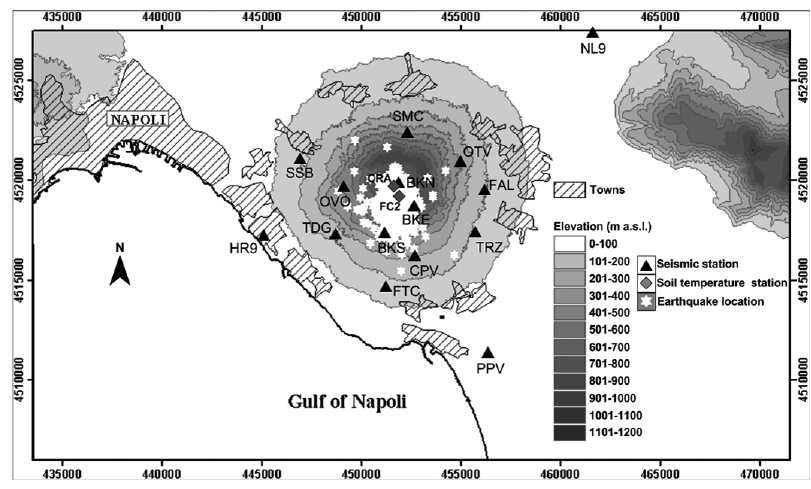
Figure 1. Map of the Vesuvius area plotting the locations of earthquakes and stations of the seismic and geochemical surveillance